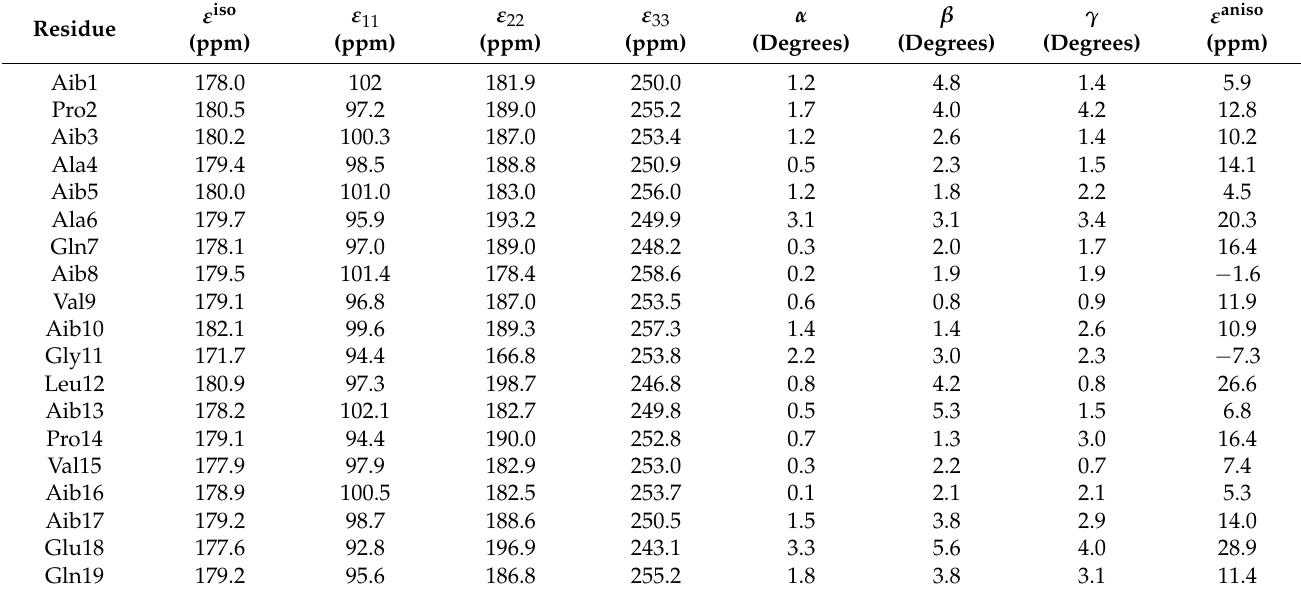
Table 3. Predicted values of the 13 C SSNMR parameters of carbonyl carbons in ALM-E18